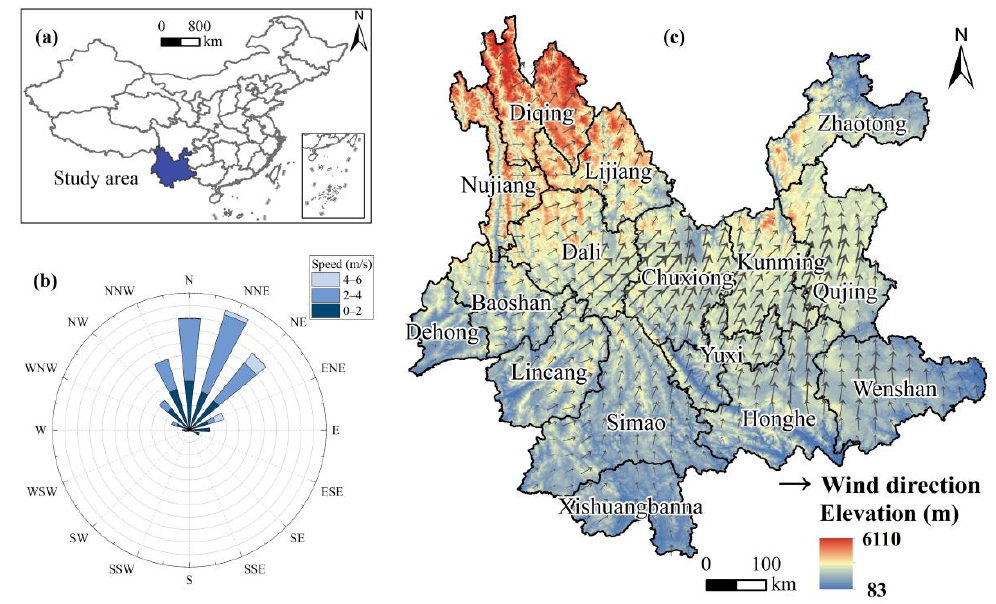
Figure 1. Study area. ( a ) Location of Yunnan in China; ( b ) predominant wind directions and speeds (m/s); ( c ) spatial distributions of elevation and wind speed magnitude and direction.